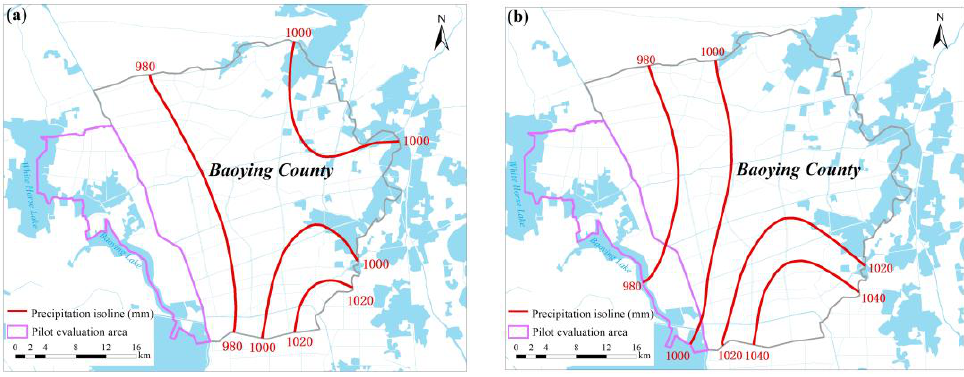
Figure 3. Map of Precipitation Contour. ( a ) 1956 – 2019. ( b ) 1980 – 2019.